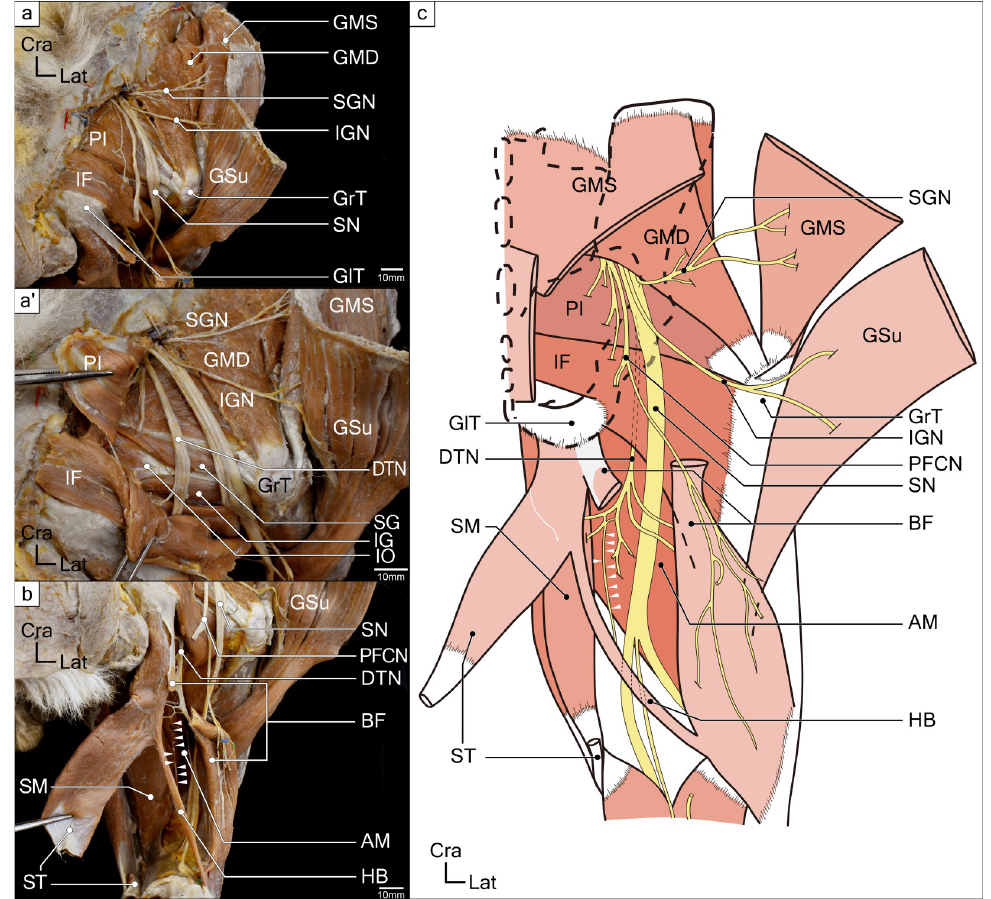
Fig 2. Deep layer muscles of gluteal and posterior femoral regions in a koala right hind-limb. ( a ) The deep gluteus muscles and several nerves including muscular branches are shown. ( a ) The deep tibial nerve (DTN) and deep gluteus muscles deep to the piriformis (PI) and ischiofemoralis (IF) are shown. ( b ) The innervating branches to the thigh flexors are shown. ( c ) Schematic drawing of deep gluteal muscles, thigh flexors, and innervating branches. White arrowheads indicate the innervating branch from the deep tibial nerve (DTN) to the hamstring bundle (HB). Abbreviations: AM, adductor magnus; BF, biceps femoris; DTN, deep tibial nerve; GlT, gluteal tuberosity; GMD, deep layer of the gluteus medius; GMS, superficial layer of the gluteus medius; GrT, greater trochanter; GSu, gluteus superficialis; HB, hamstring bundle; IF, ischiofemoralis; IG, inferior gemellus; IGN, inferior gluteal nerve; PFCN, posterior femoral cutaneous nerve; PI, piriformis; SG, superior gemellus; SGN, superior gluteal nerve; SM, semimembranosus; SN, sciatic nerve; ST, semitendinosus; VL, vastus lateralis.